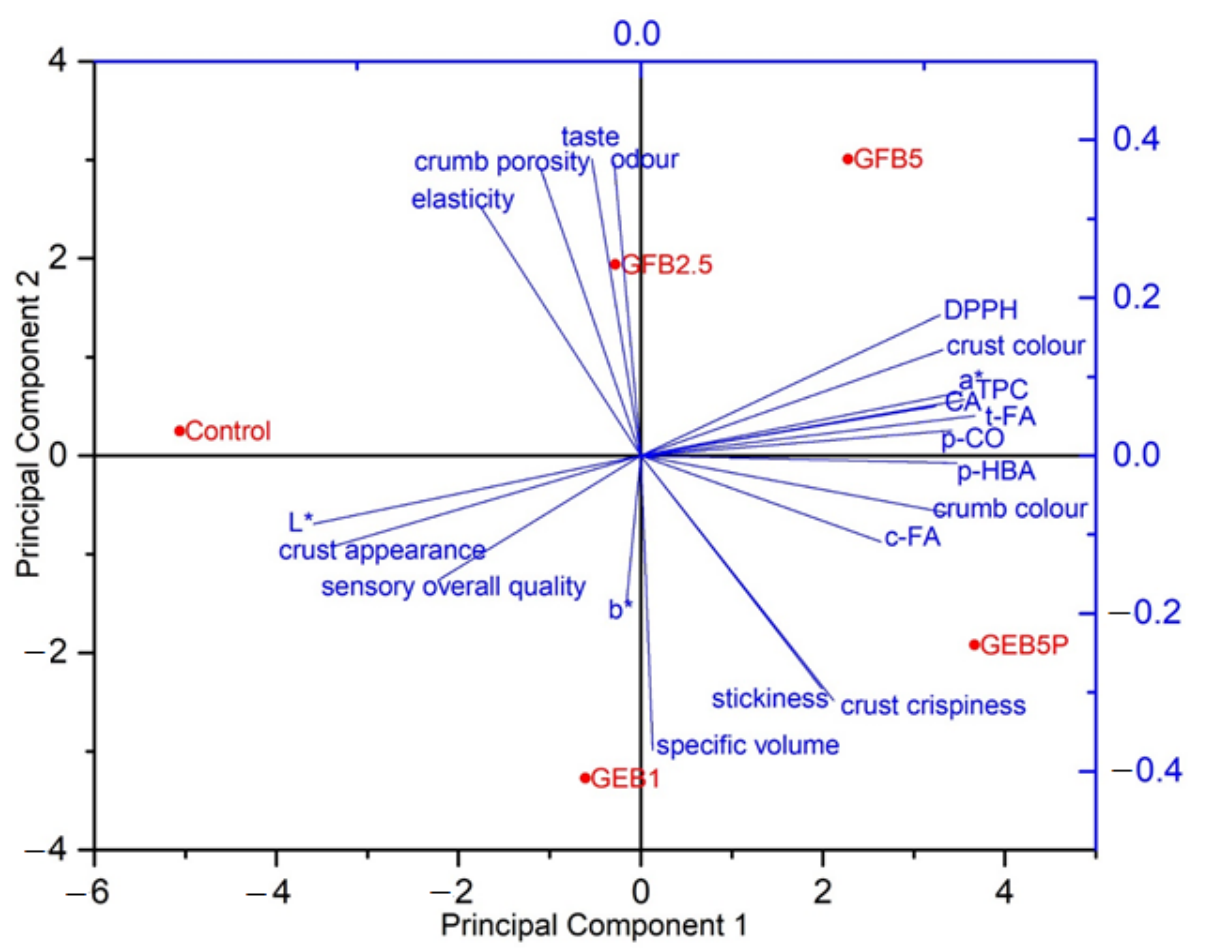
Figure 4. Plot of the variables and bread samples on the first and second principal component axes. Control: white wheat bread; GEB1: wheat bread supplemented with 1% “germinated + enzymatic treated” spelt flour; GEB5P: wheat bread supplemented with 5% pasteurised (30 min, 85 ◦ C) “germinated + enzymatic treated” spelt flour; GFB2.5: wheat bread supplemented with